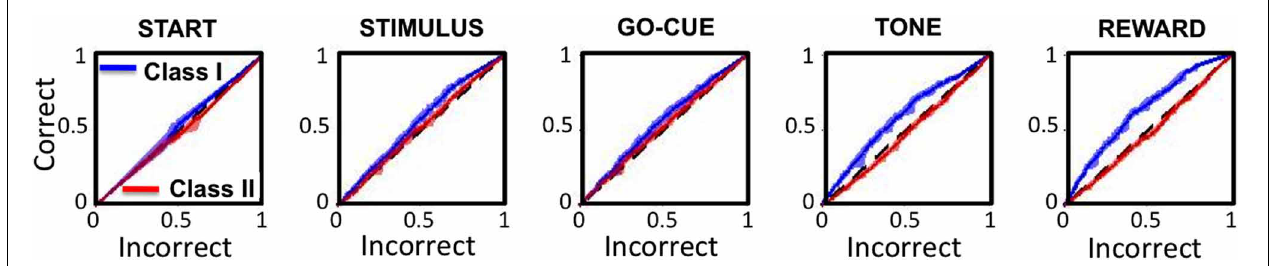
FIGURE 7 | Receiver operating characteristics (ROC curves) for Class I (blue traces) and Class II (red traces) neurons for each epoch of the task. The x- and y-axes represent the